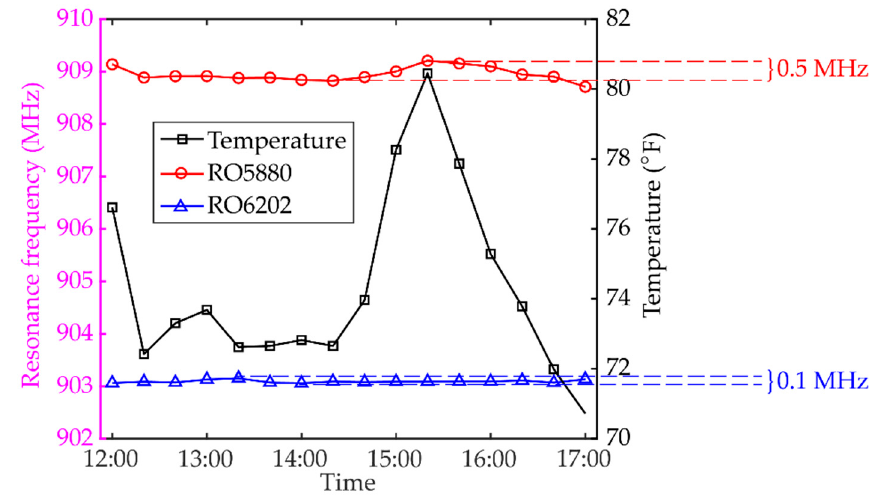
Figure 6. Resonance frequency change due to temperature fluctuation.